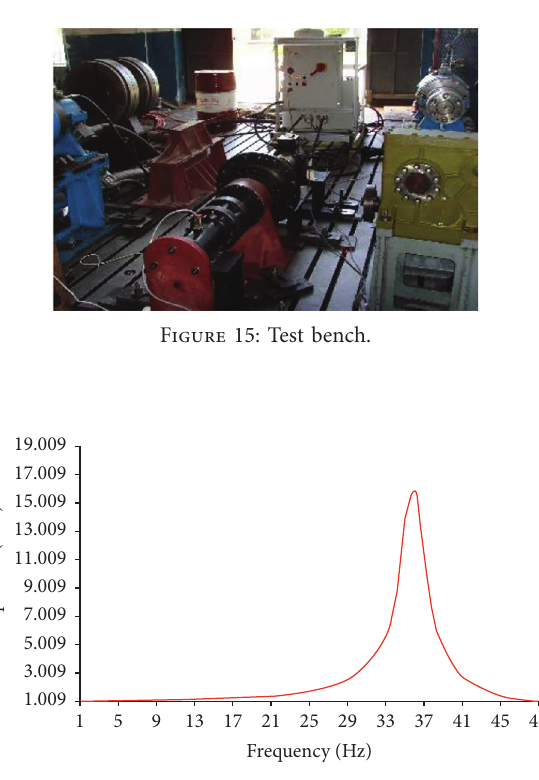
Figure 16: The fitting curve of frequency response.